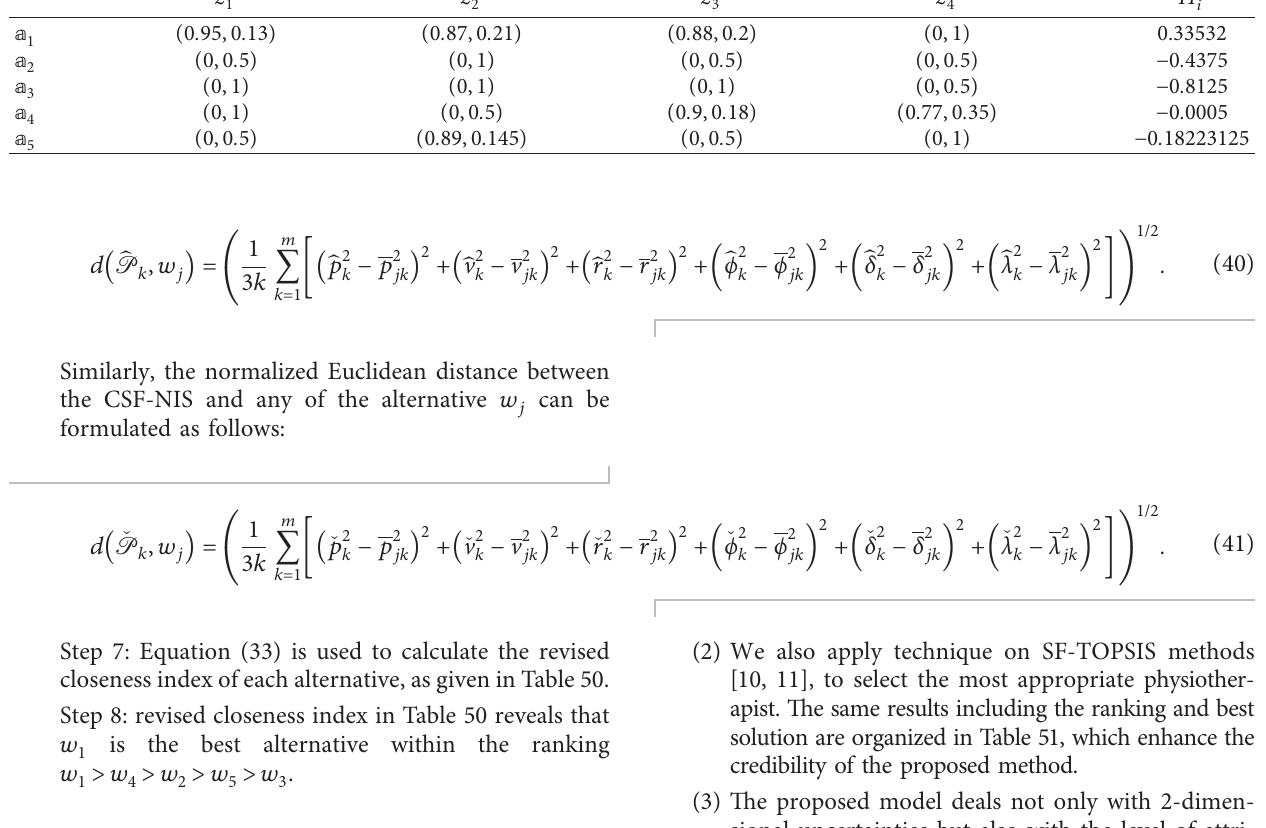
Table 39: Tabular representation of Choice value of PF 6 S